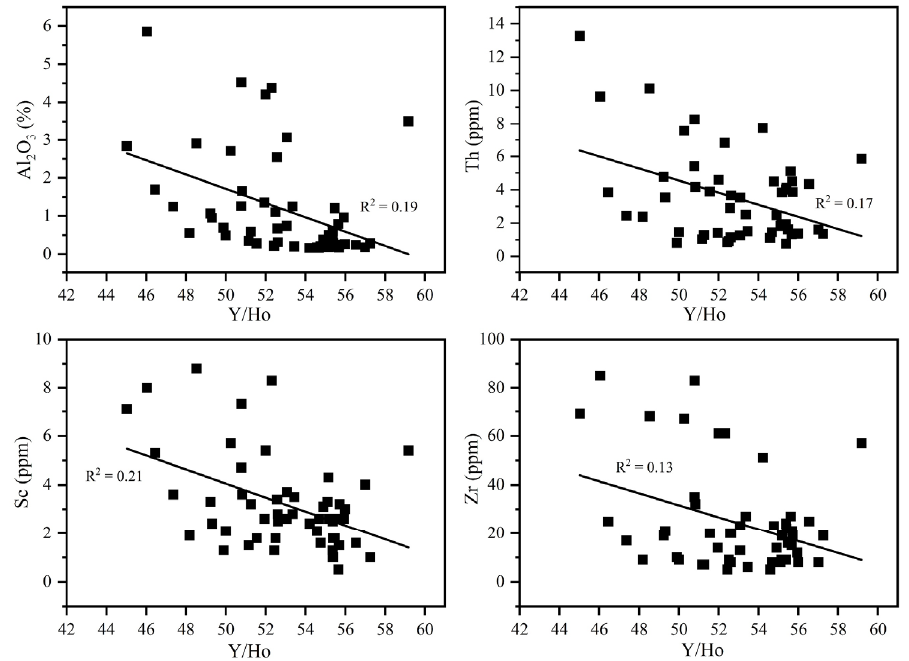
Figure 7. Scatter diagrams between Y/Ho and trace elements (Al 2 O 3 , Th, Sc, and Zr) in Zhijin phosphorus rocks series.